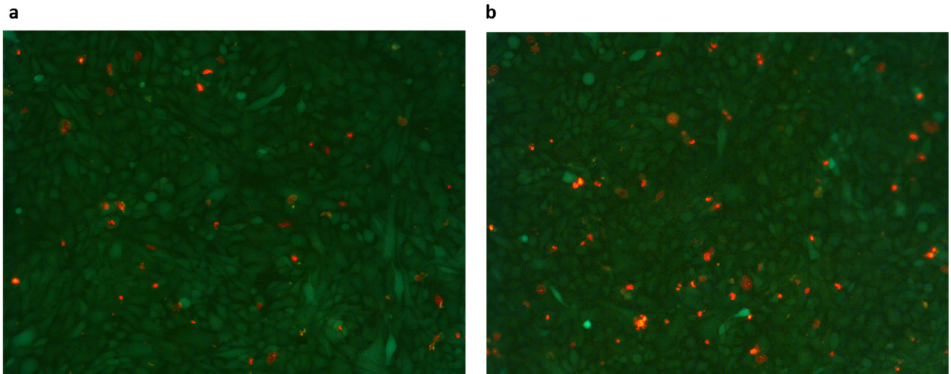
Figure 5. Representative image of gel before ( a ) and after ( b ) μ measurement. Cells were marked with Live and Dead Cell Assay (ab115347, Abcam, Cambridge, UK), which labels live cells in green and dead cells in red.